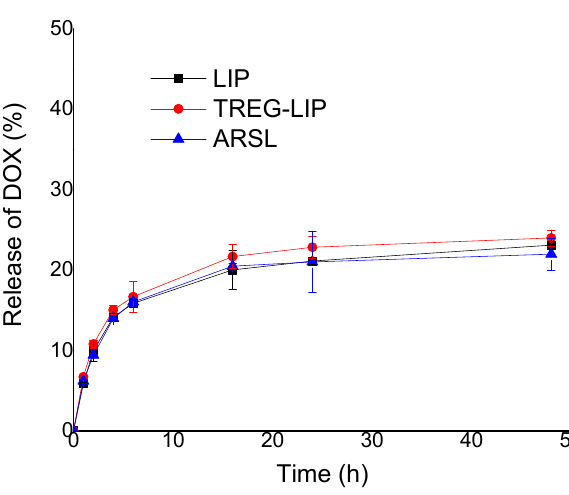
Figure 6. DOX-release (%) from various types of vesicles during incubation at 37 ◦ C for 48 Figure 6. DOX ‐ release (%) from various types of vesicles during incubation at 37 °C for 48 h.